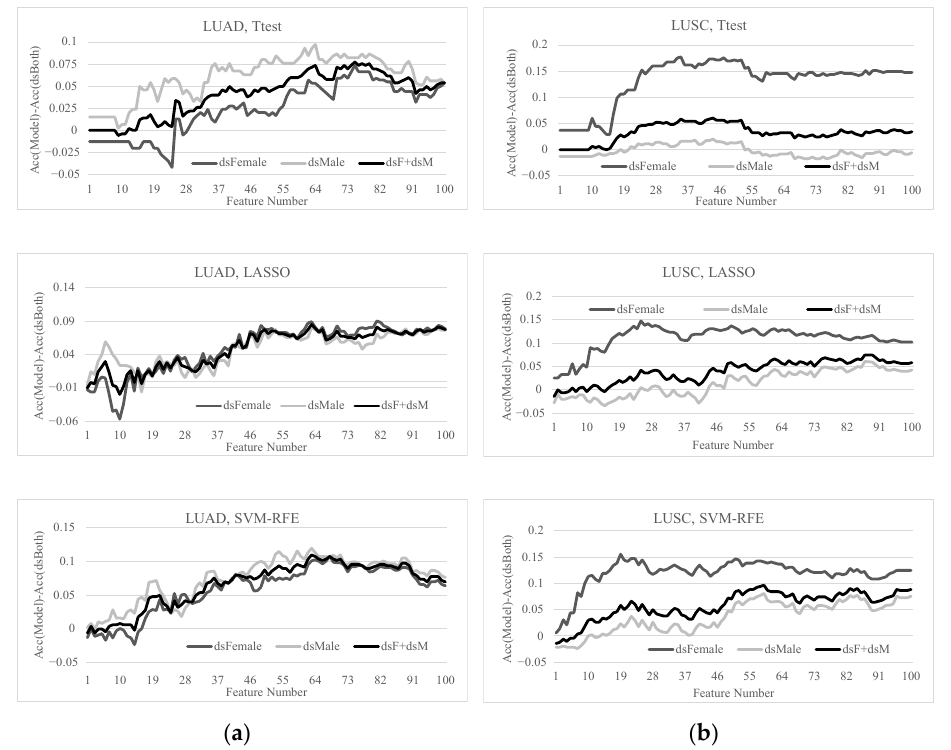
Figure 6. SVM classification performances of the top 100 features in LUAD and LUSC. The features were ranked by Ttest, LASSO and SVM-RFE, respectively. The horizontal axis gives the number of features used in each data point. The vertical axis gives the detection accuracy of each model minus that of the dsBoth dataset. The improvements of the datasets dsFemale/dsMale/dsF+dsM were illustrated for the two lung cancer subtypes ( a ) LUAD and ( b ) LUSC.